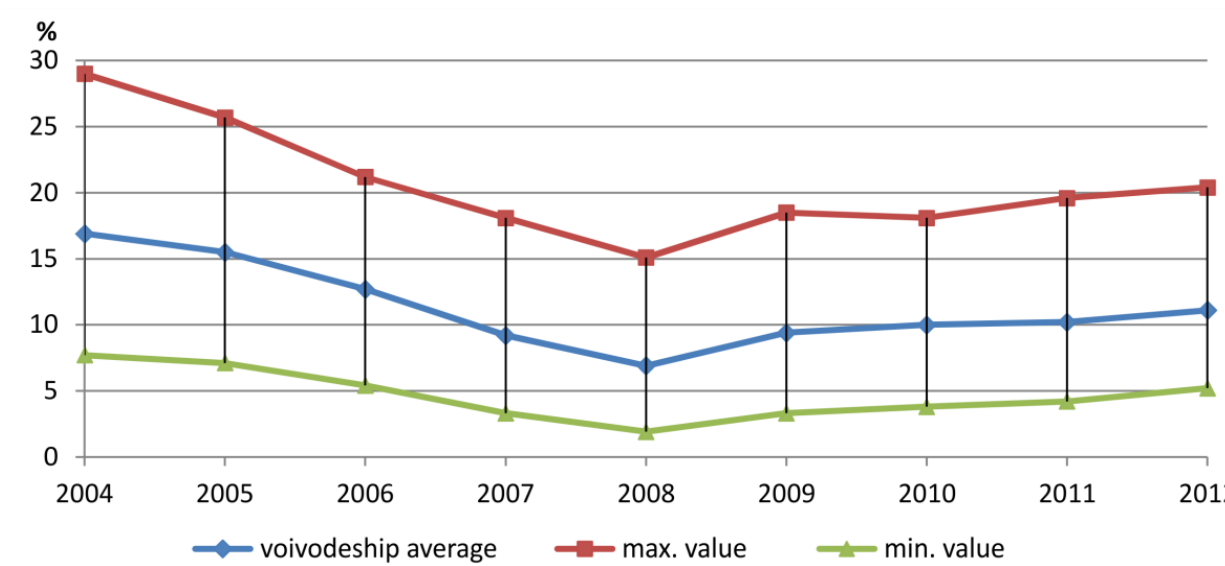
Fig. 4. Unemployment rate in the Silesian voivodeship in the period from 2004 to 2012 (after Sitek et al.,